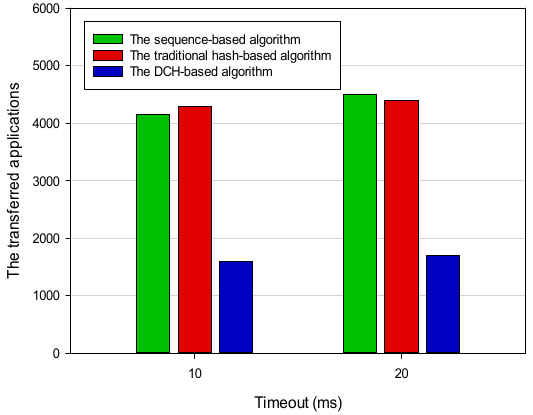
Figure 16. The transferred applications based on different deploying algorithms.